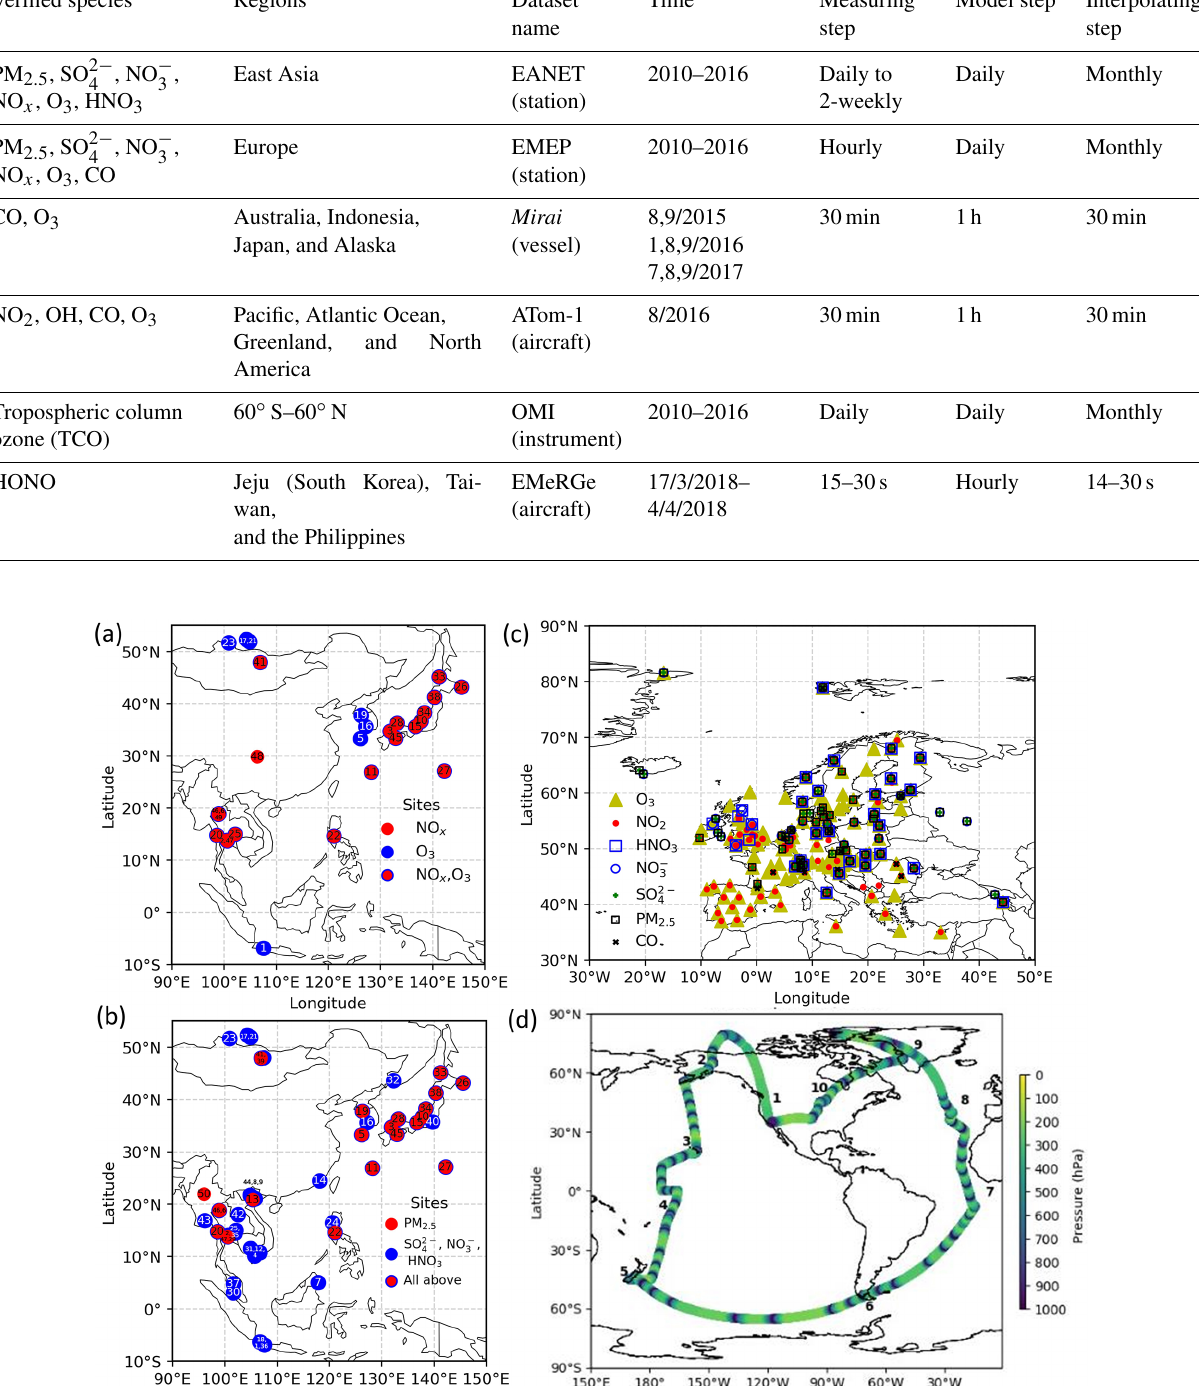
, NO − , and HNO 3 , (c) EMEP stations, 4 3